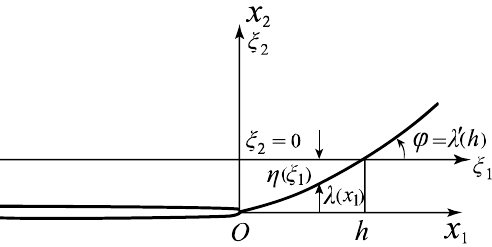
Figure 2: Coordinate systems for a kinked and curved